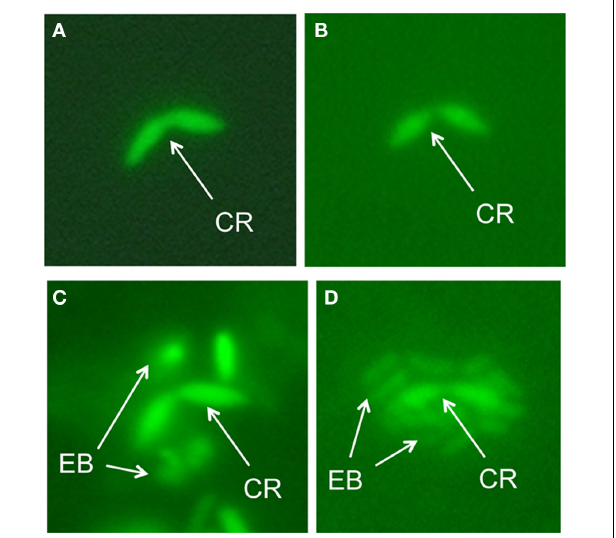
FIGURE 1 | CFDA-SE stained phototrophic consortia. CR, central rod; EB, epibiont. (A,B ) 2 (A) and 5min (B) of staining; only the central bacterium is visible. (C) 12min of staining; epibionts become visible. (D) 15-min staining; whole consortium